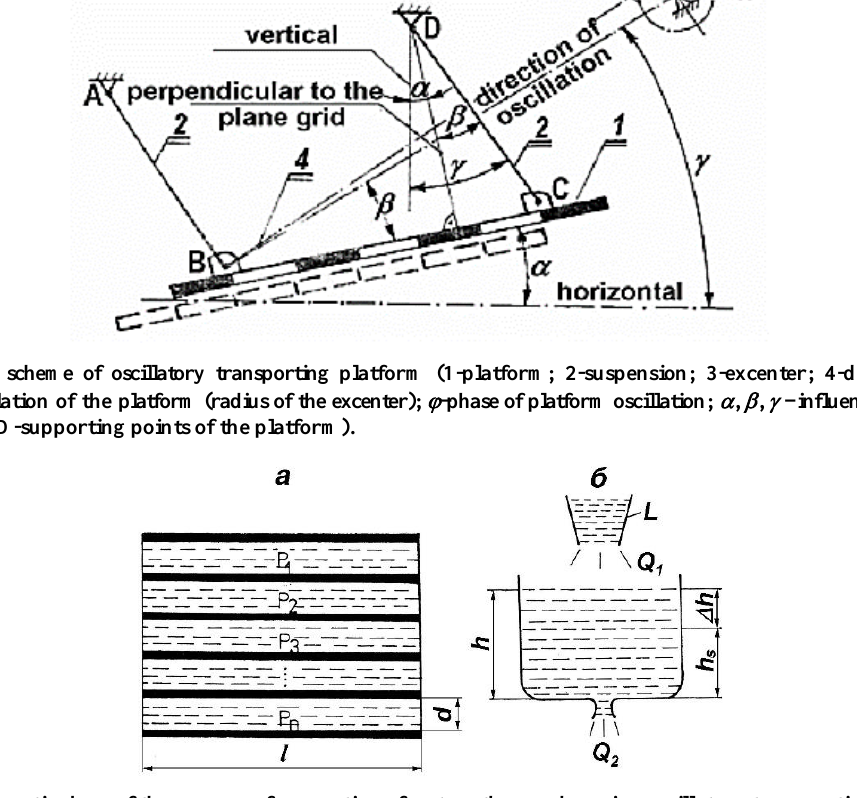
Figure 2. Schematic shew of the process of separation of wet earth mass by using oscillatory transporting platform.